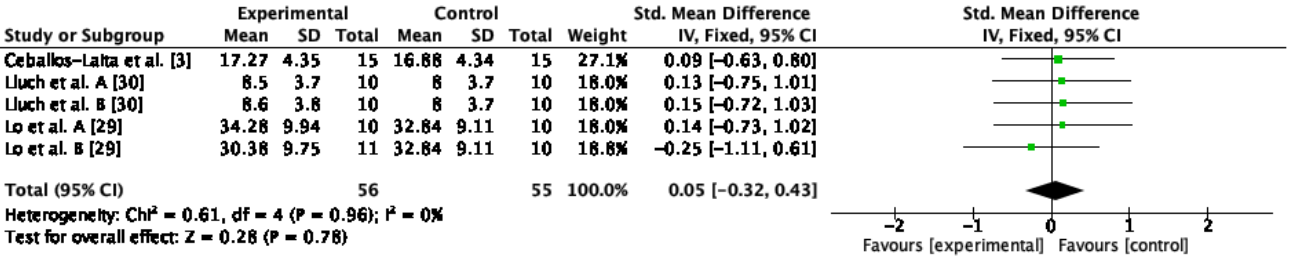
Figure 7. Forest plot of external rotation strength for conservative therapy versus control/sham. Lluch et al. A. compared manual therapy versus control intervention. Lluch et al. B compared the manual contact versus control intervention. Lo et al. A compared KT versus control intervention. Lo et al. B compared stretching versus control intervention.